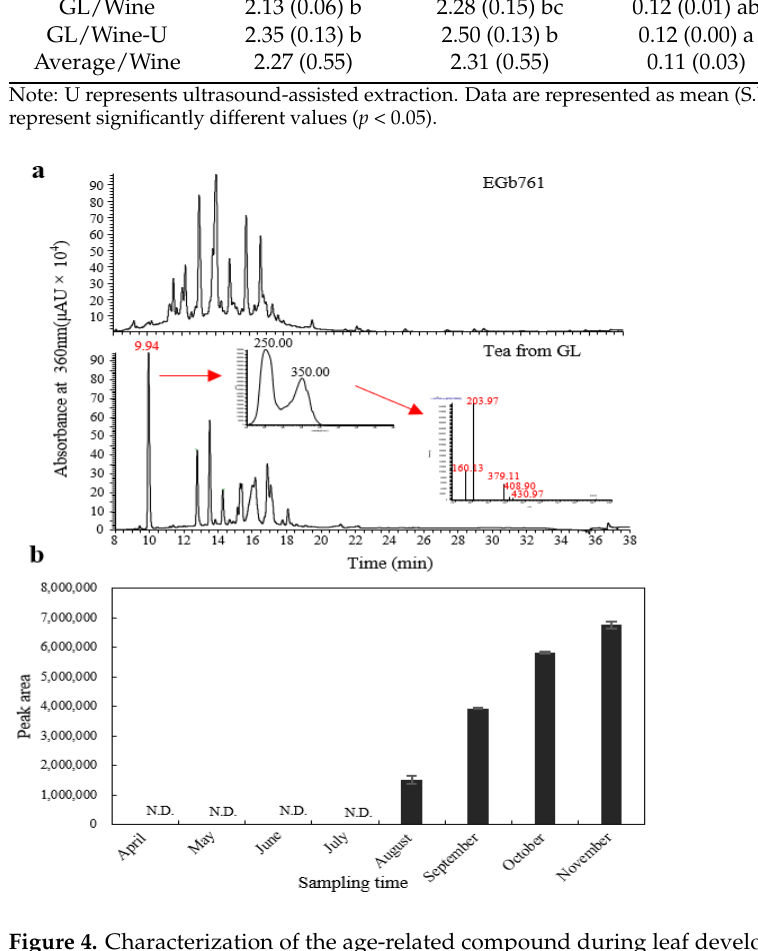
Figure 4. Characterization of the age-related compound during leaf development. ( a ) HPLC chro- matograms of EGb761 (upper panel) and ginkgo tea from GL (lower panel) with the specific UV spectrum and mass spectra. ( b ) The accumulation profiles of the age-related compound at 9.94 min during leaf development from April to November. Data are presented as mean ± SD. n = 3.